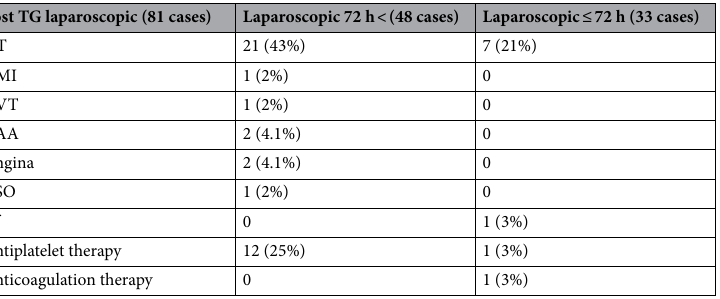
Table 6. Cardiovascular disease and antithrombotic therapy. Approximately 25% of patients continued antiplatelet or anticoagulant therapy.